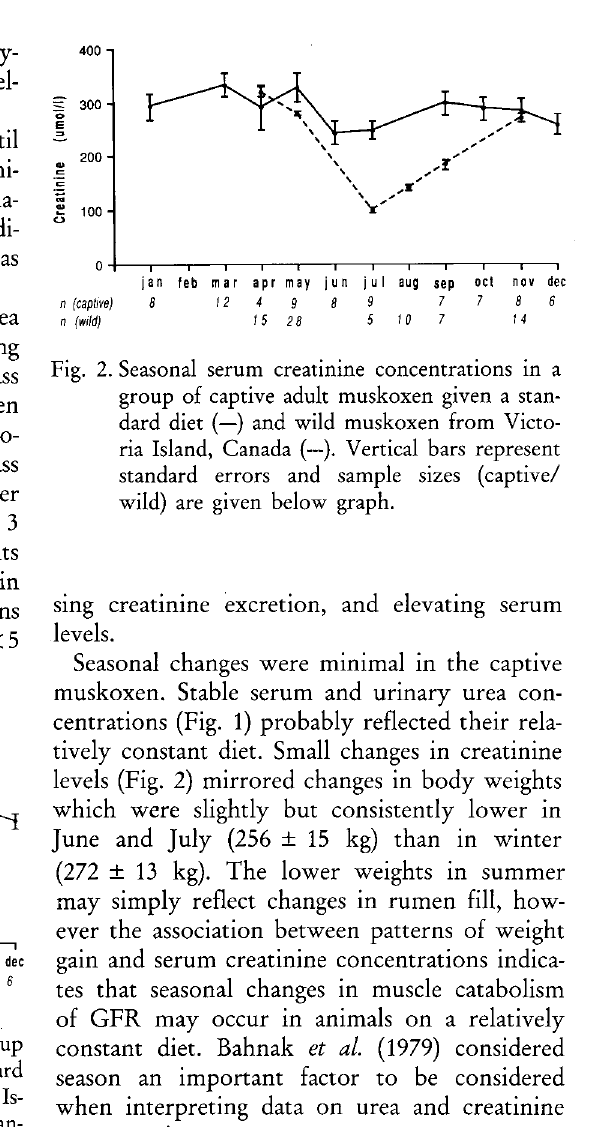
Fig. 1. Seasonal serum urea concentrations in a group of captive adult muskoxen given a standard diet (—) and wild muskoxen from Victoria Is land, Canada (—). Vertical bars represent stan dard errors and sample sizes (captive/wild) are given below graph.